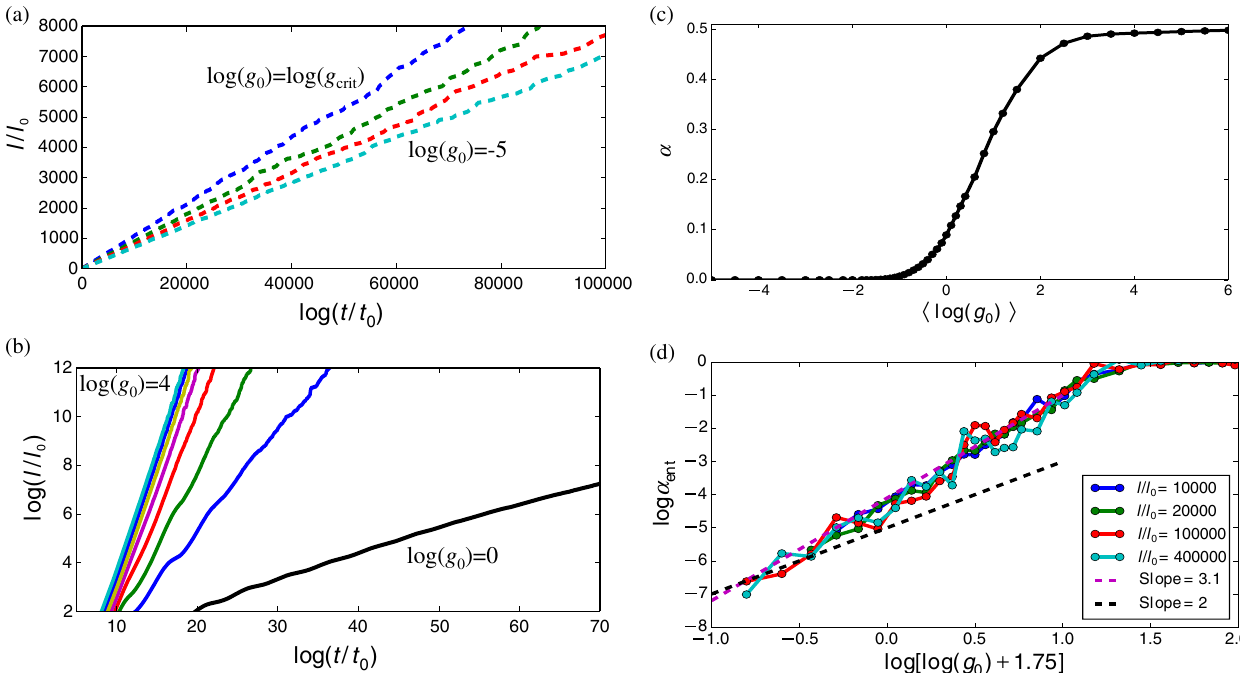
FIG. 5. (a) The relation between length scale and time obtained from the RG flow in the many-body localized phase is logarithmic, i.e., l ∼ S ∼ log t . (b) In the delocalized phase, the RG flows give a power-law scaling between length and entanglement thermalization time, l ∼ t α ent . As explained in the text, the corresponding transport exponent α ¼ α the tuning parameter reveals a continuous transition from a localized phase to a subdiffusive but thermal Griffiths regime, i.e., with 0 < α < 1 = 2 . The transport becomes diffusive, α ¼ 1 = 2 , deep in the delocalized phase. (d) Vanishing of α plotted on a log-log plot is consistent with the anticipated scaling α